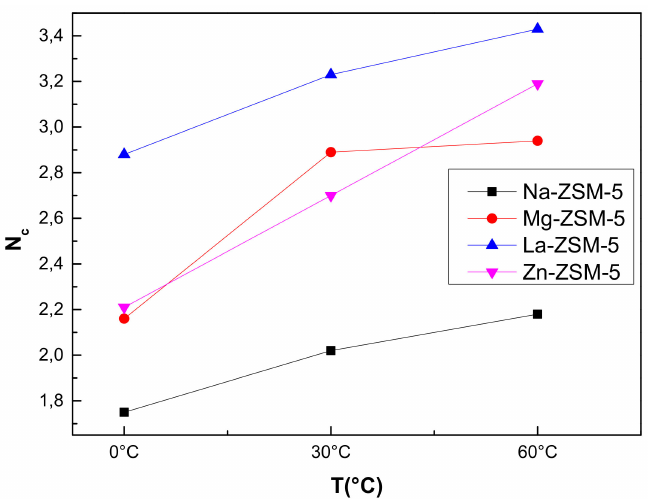
Figure 7. Effect of temperature on the total number of formed layers of CO 2 molecules on the Na-ZSM-5, Mg-ZSM-5, La-ZSM-5 and Zn-ZSM-5 adsorbents.